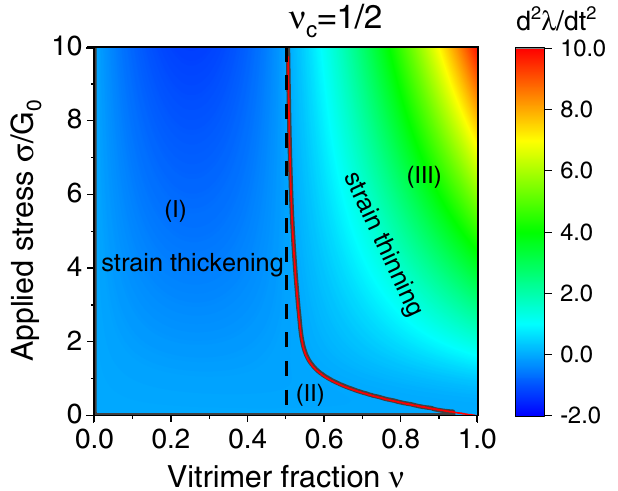
Fig.5|Acceleration, d λ 2 / dt 2 ,ofmaterialextensionintheshorttimelimit, t → 0, in the space of (vitrimer fraction ν , stress). ν c =1/2 denotes the critical vitrimer fraction, below which the material can only exhibit strain thickening regardless of the applied stress. Positive and negative accelerations represent shear thinning [Region (III)] and thickening [Region (I) and (II)], respectively. The red line (the boundary between regions) is ν *( σ 0 ) calculated from the full numerical solution, and the black line is represents the approximate low-deformation limit by Eq. (18); they overlap indicating the accuracy of approximation.